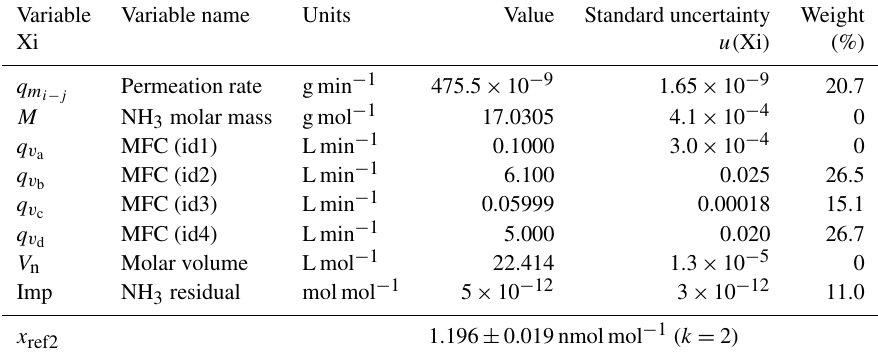
Table 3. The uncertainty budget of the amount-of-substance fraction of one of the ammonia RGMs generated after the second dilution stage. The contribution, in percent, of each variable to the overall uncertainty is indicated in the weight column. The last row shows the amount-of-substance fraction value and its expanded uncertainty. k is the coverage factor of the uncertainty.